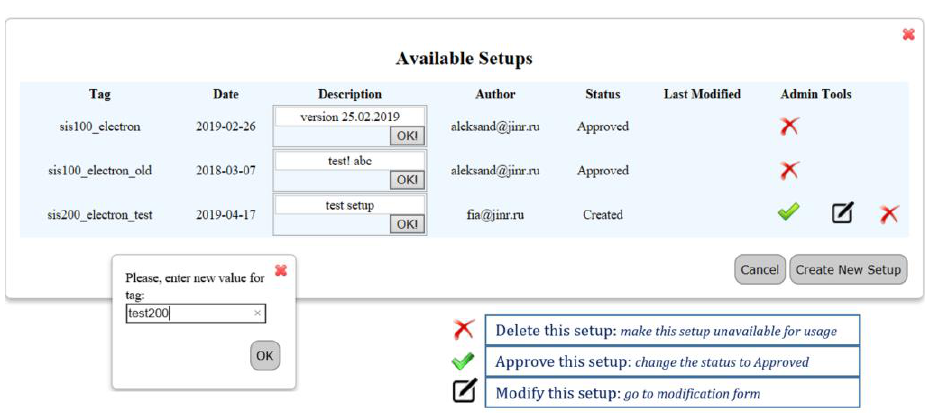
Fig. 6. Web-interface: Edit